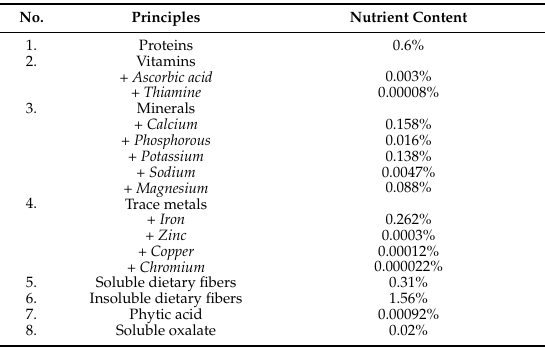
Table 5. Nutritional content of P.